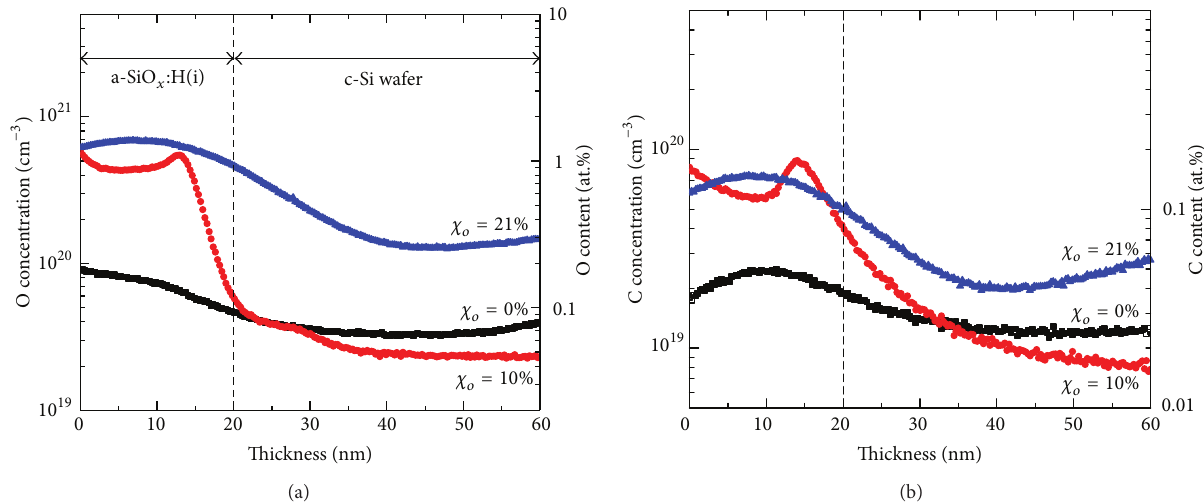
Figure 6: Depth resolved (a) O and (b) C concentrations obtained from TOF SIMS. The respective elemental content in a-Si host is calculated based on standard c-Si atomic concentration. Both O and C concentrations show increasing trend with respect to CO 2 partial pressure during deposition. The highest C content achievable in this work is about 0.1 at.%.